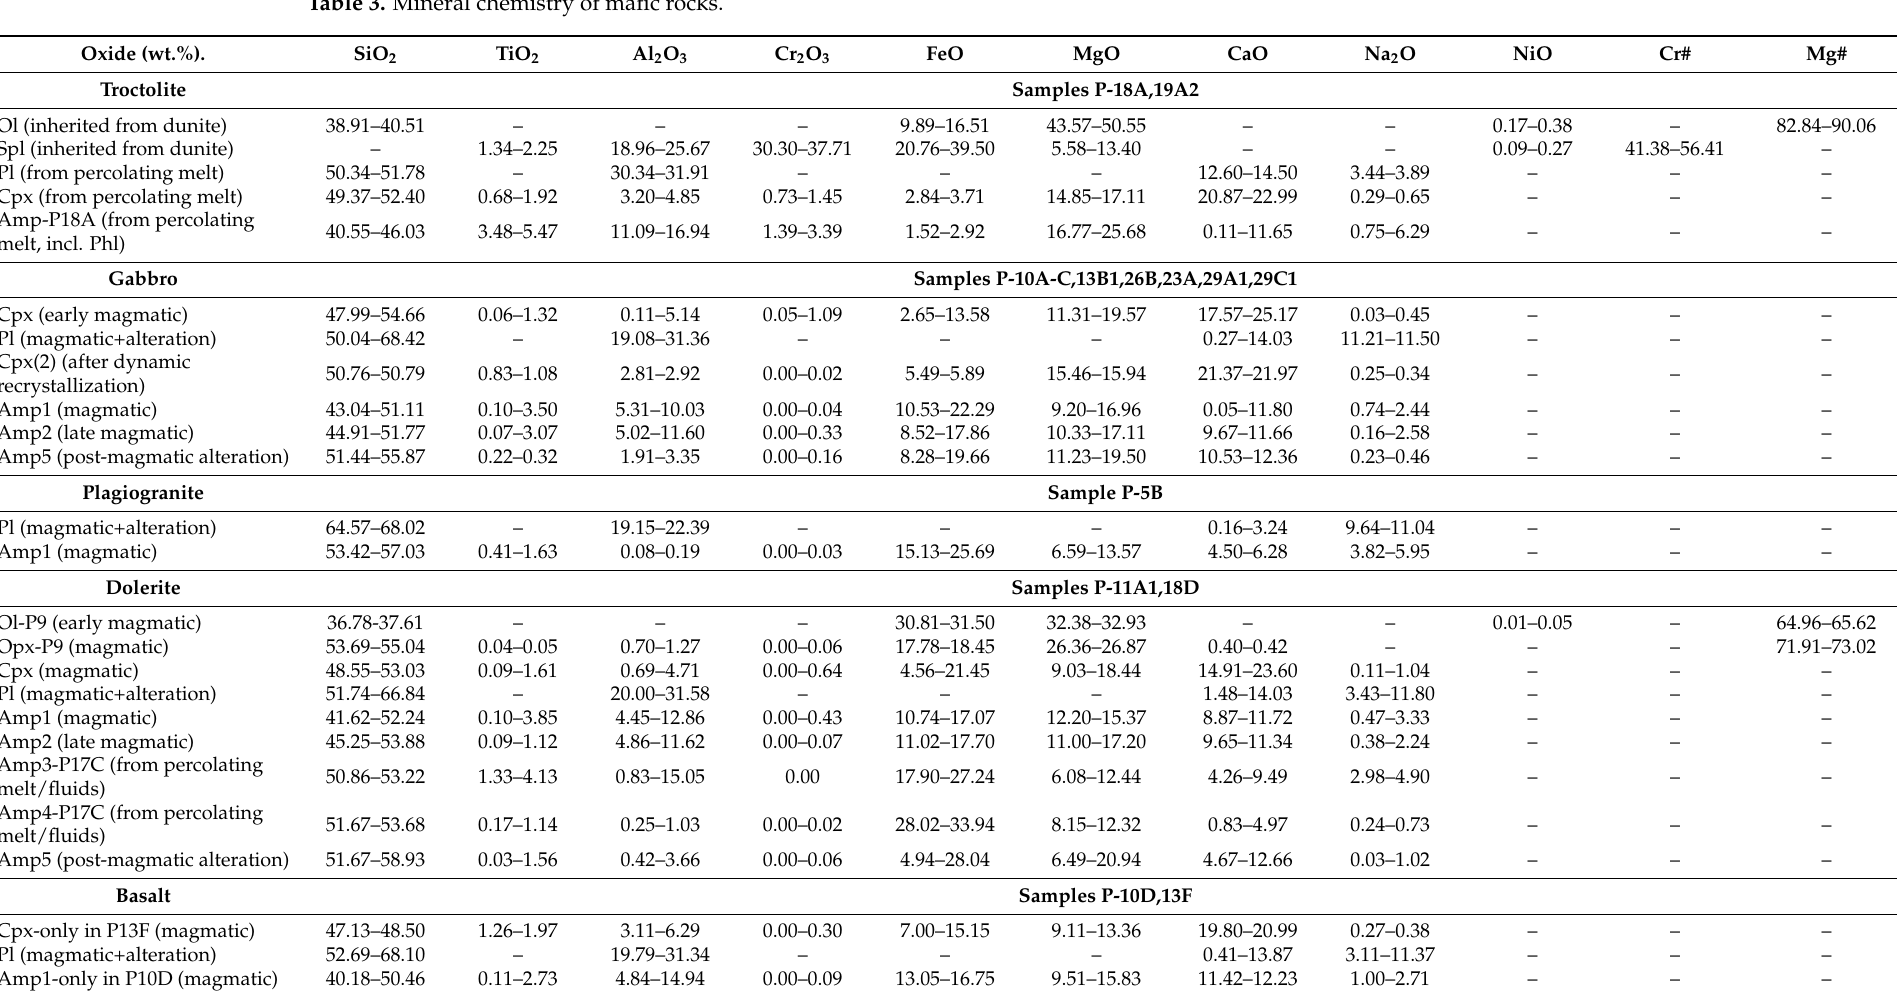
Table 3. Mineral chemistry of mafic